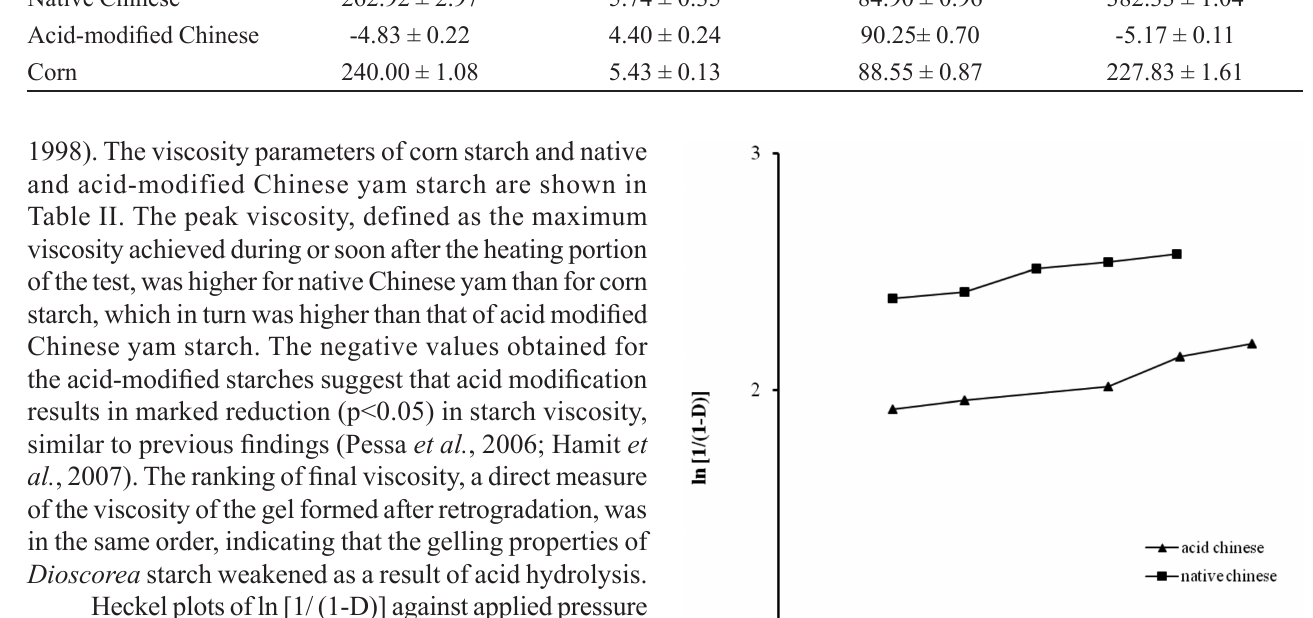
TABLE II - Rheological properties of the starches (Mean ± SD, n = 4) Starch